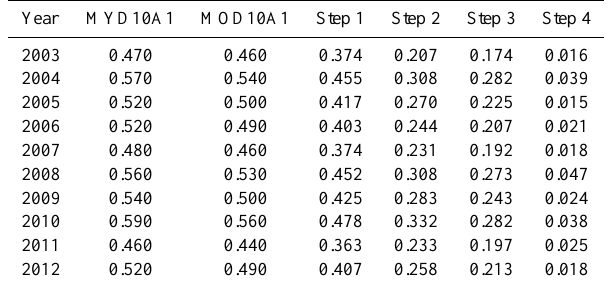
Table 5. Mean annual cloud cover fraction remaining after each step for the Po River